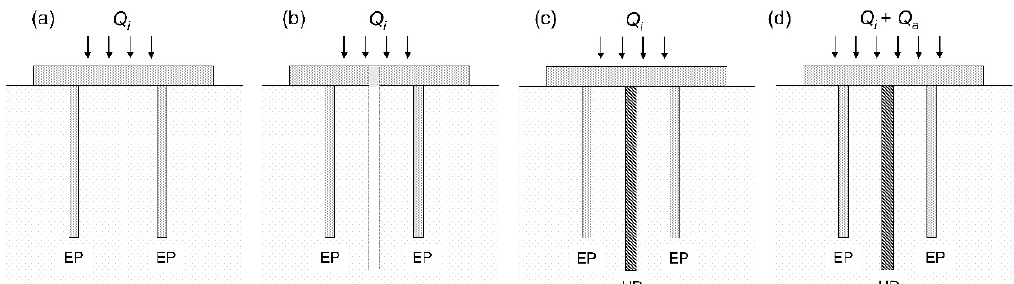
Figure 1. Construction procedure for the underpinning with the consideration of additional loading. ( a ) Existing foundation (EP) subjected to superstructural load ( Q i ); ( b ) boring; ( c ) underpinning by new pile (UP); and ( d ) additional loads ( Q a ) applied on underpinned